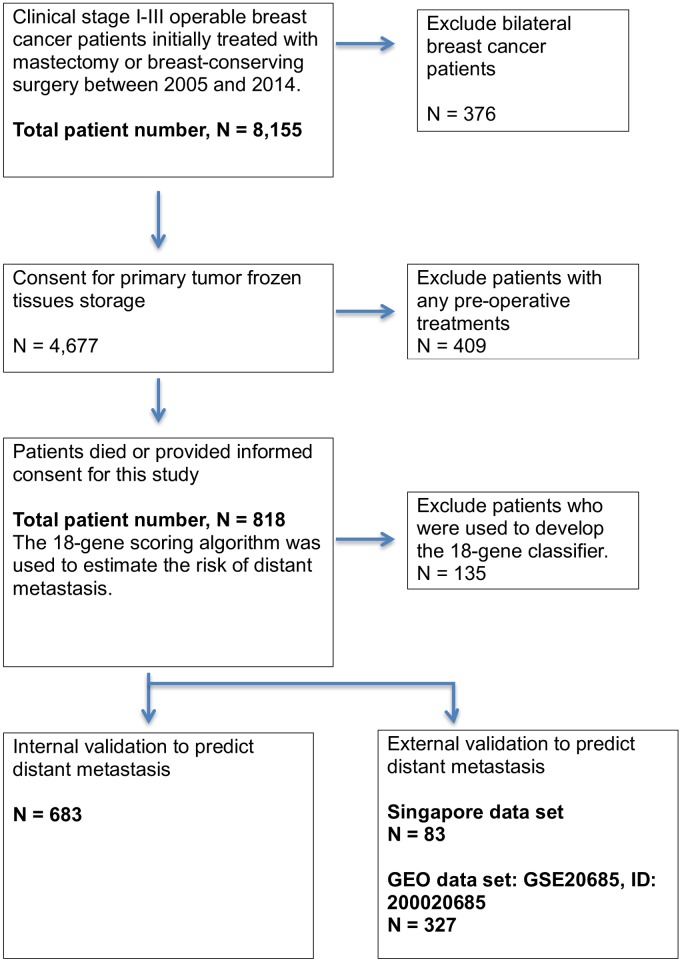
Flow of patient selection and external validation.